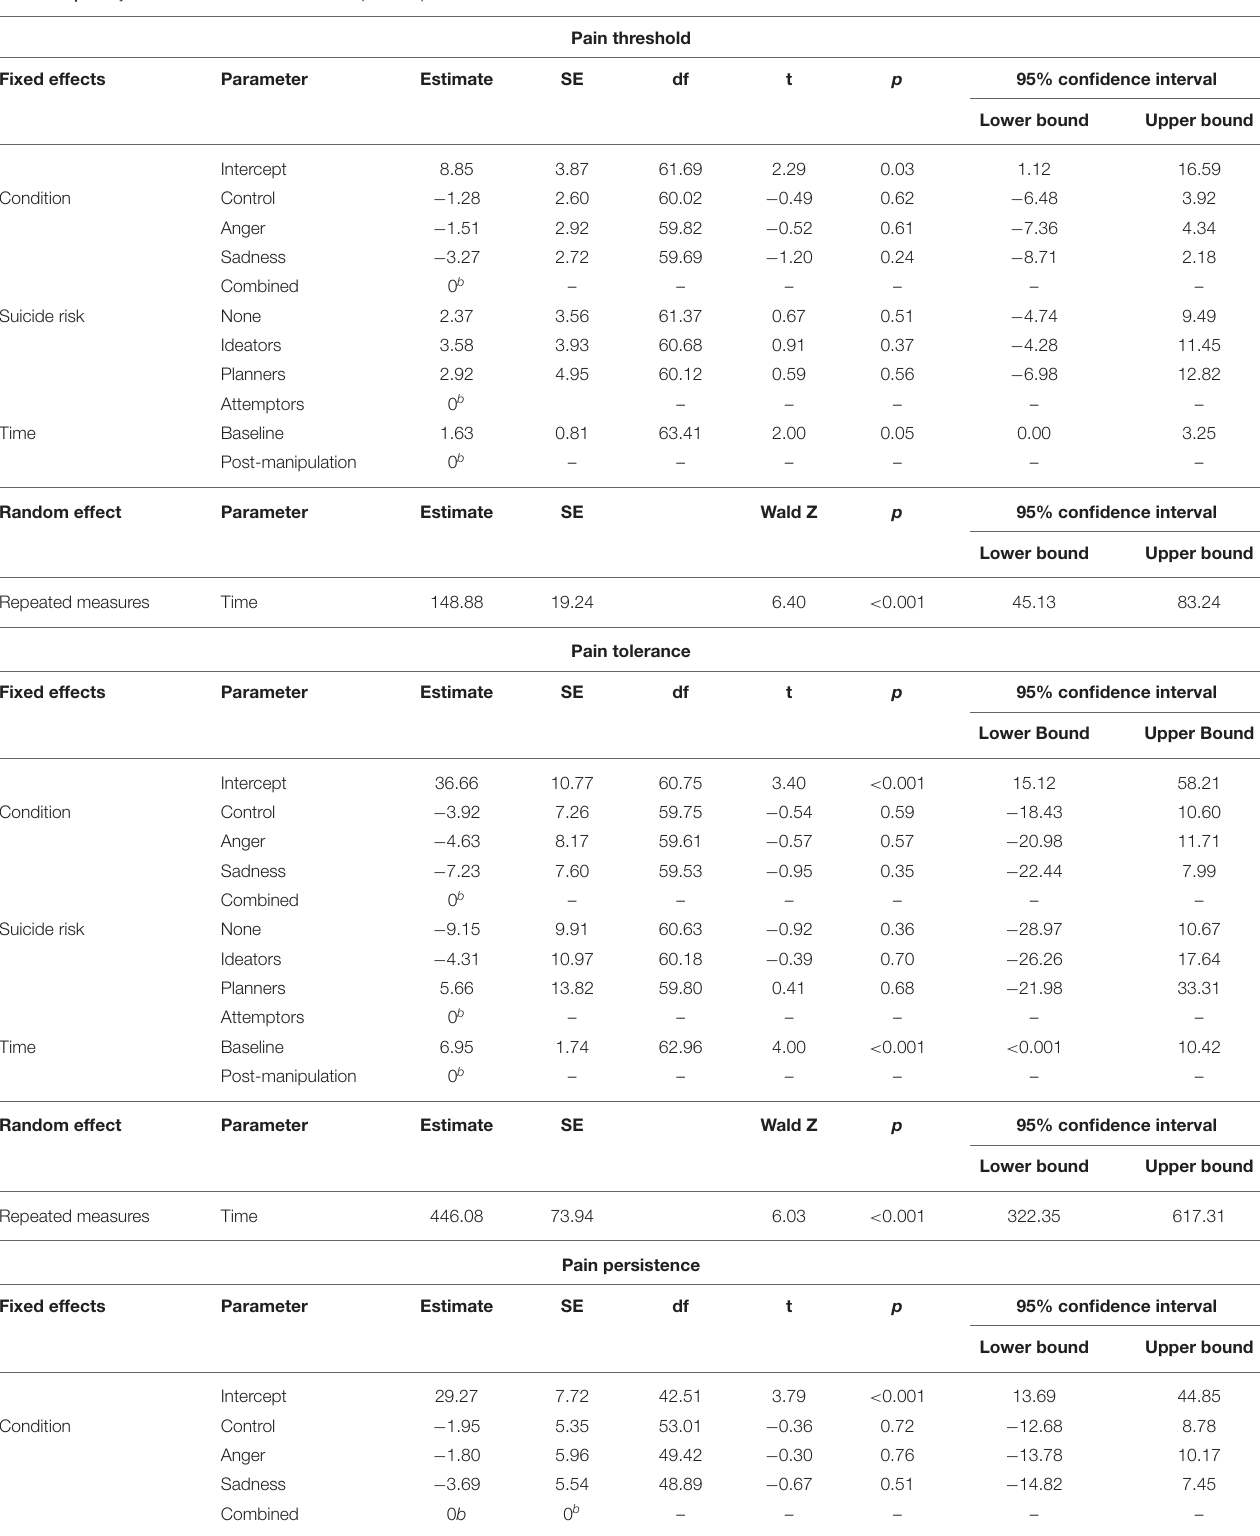
TABLE 5 | Study 2 fixed and random effects for pain